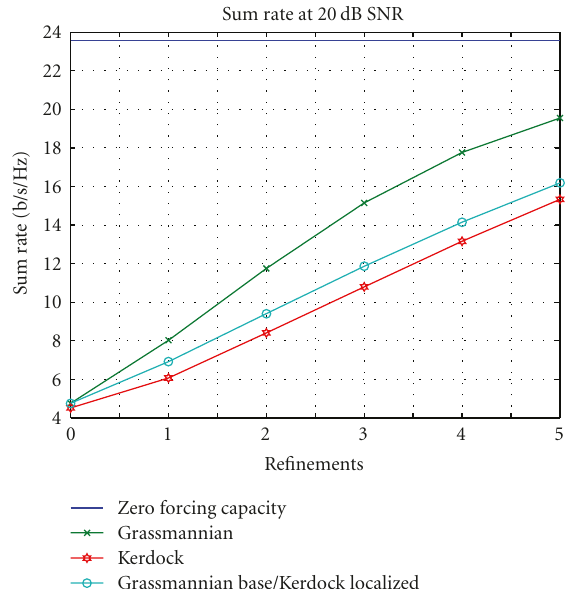
Figure 6: Sum rate performance of multiuser MIMO with N t = U = 4 at SNR = 20dB for the Grassmannian, Kerdock, and Grassmannian/Kerdock ring codebooks.